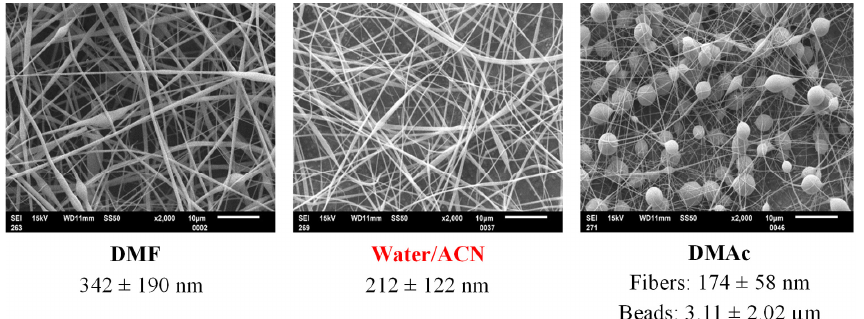
Figure 2. Representative SEM images obtained for the ESP of CDLA in different solvents, DMF, W/A, DMAc (ESP parameters: voltage—15 kV, working distance—13 cm, flow rate—0.1 mL/h, concentration—160% ( w/v )).